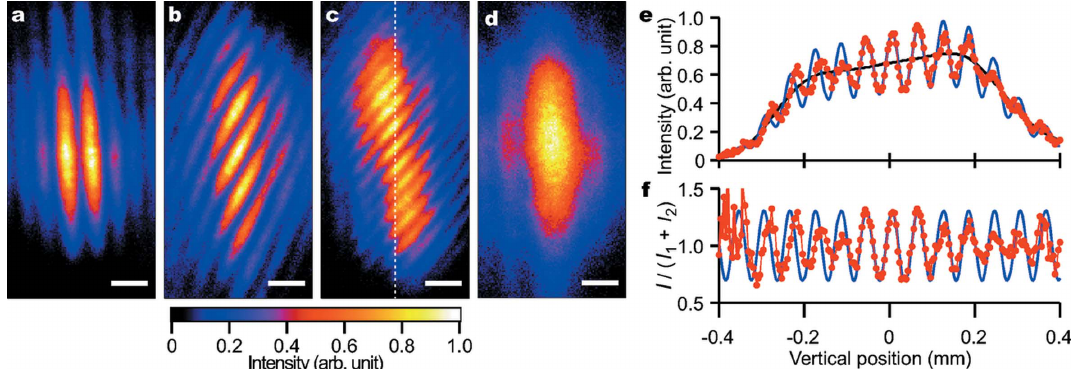
Figure 2 Examples of single-shot superimposed profiles, ( a )–( c ) with a near-zero delay and ( d ) with a delay far from zero. Each scale bar represents 100 m m. The angular deviations ( (cid:4) x , (cid:4) z ) for panels ( a )–( c ) evaluated with equation (1) are (2.0, 0.11), (1.7, (cid:3) 1.0) and (2.5, (cid:3) 2.1) m rad, respectively. The fringe profile shown in panel ( d ) originates from parasitic scattering from the edge of the BS and/or BM. ( e ) Line profile along the dashed line in panel ( c ) (symbols) and its low-pass filtered profile (black line). ( f ) Oscillatory component of the measured line profile (symbols) and a fitted cosine curve (blue line) with a fringe spacing (cid:2) z of 60.0 m m and visibility V of 0.31. The fit is performed with a region in which the modulus becomes a maximum (near position 0 in this case). The fitted function multiplied by the low-pass filtered profile is also shown in panel ( e ) (blue